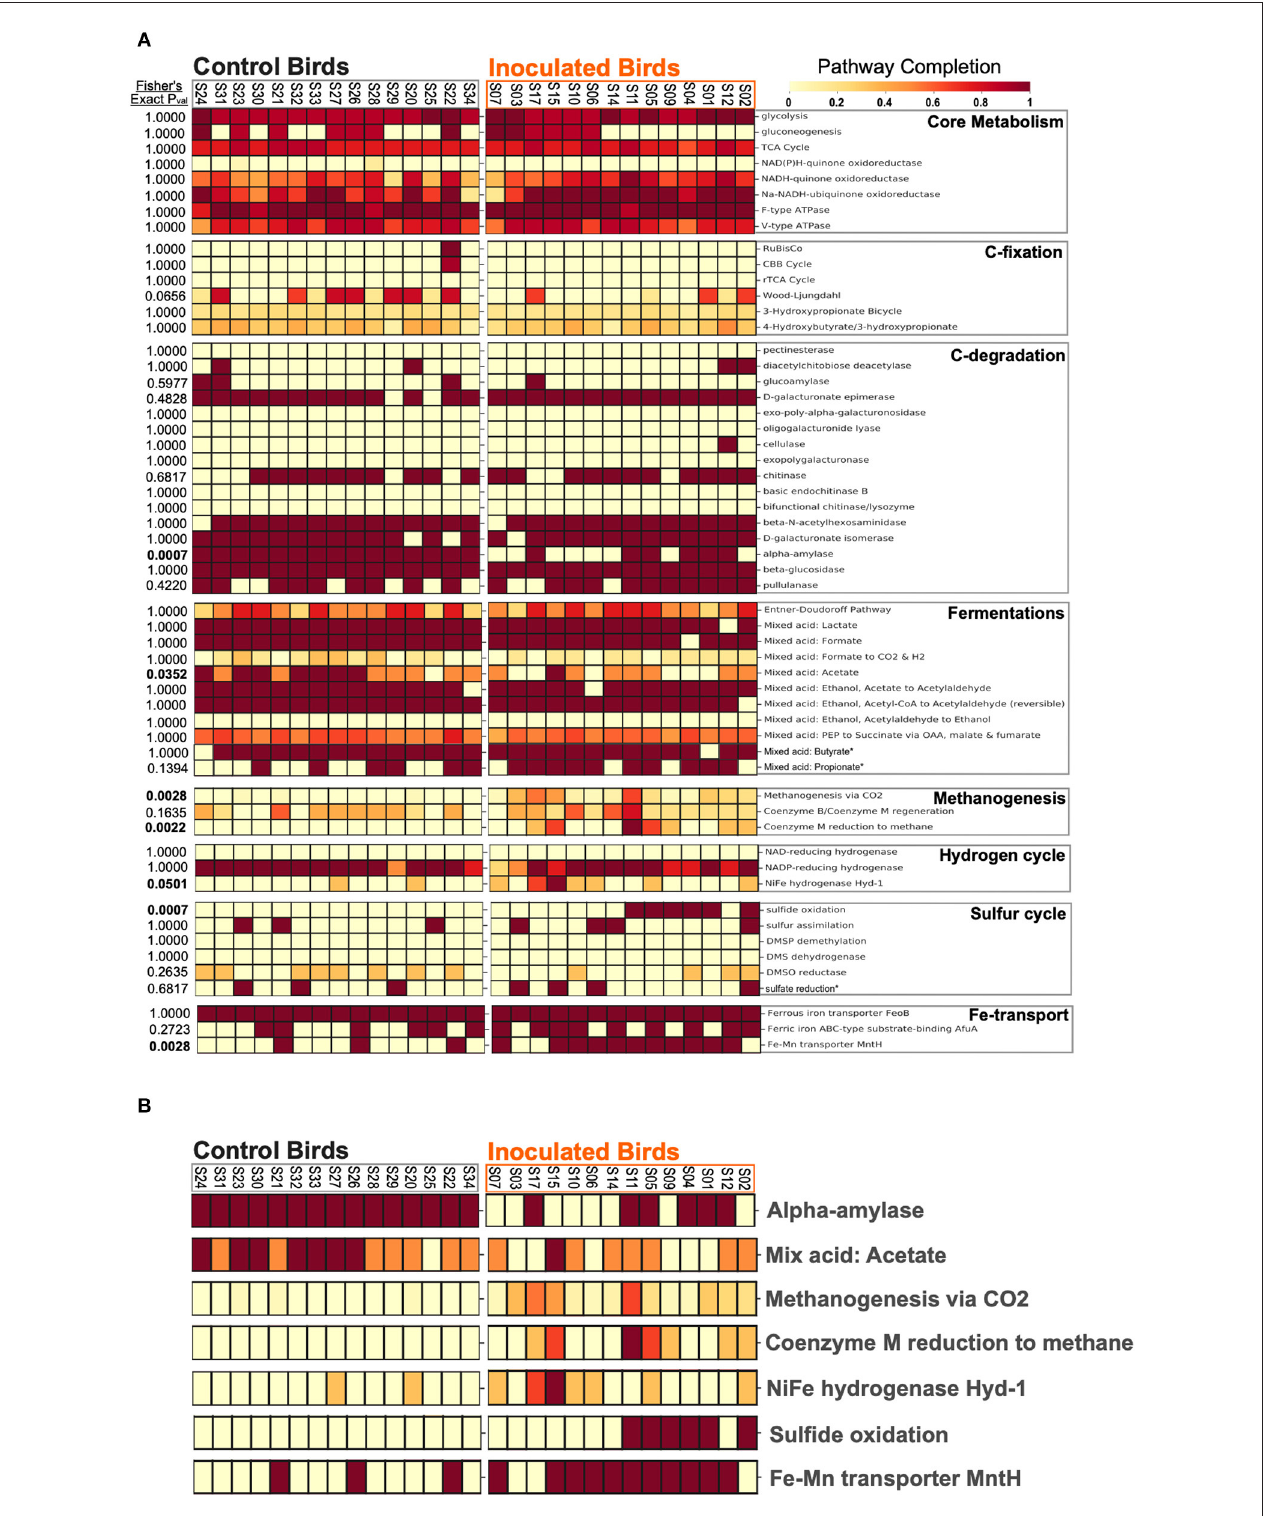
FIGURE 4 | Predicted completion of KEGG metabolism modules for (A) all cecal metagenomic assemblies. (B) Predicted metabolism modules from (A) with significant (student t -test, p -value < 0.01) differences between FMT inoculated birds and controls.